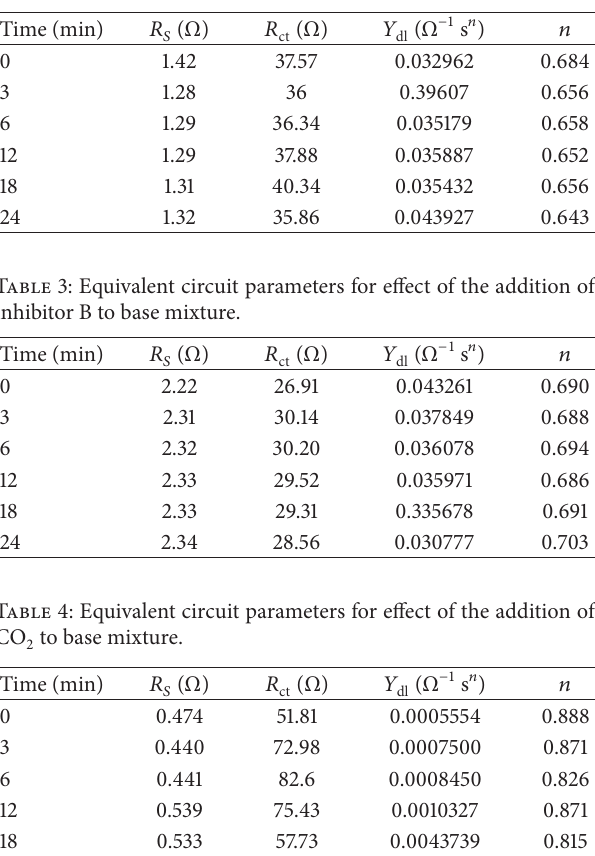
Table 1: Equivalent circuit parameters for base mixture. Table 2: Equivalent circuit parameters for effect of the addition of inhibitor A to base mixture.